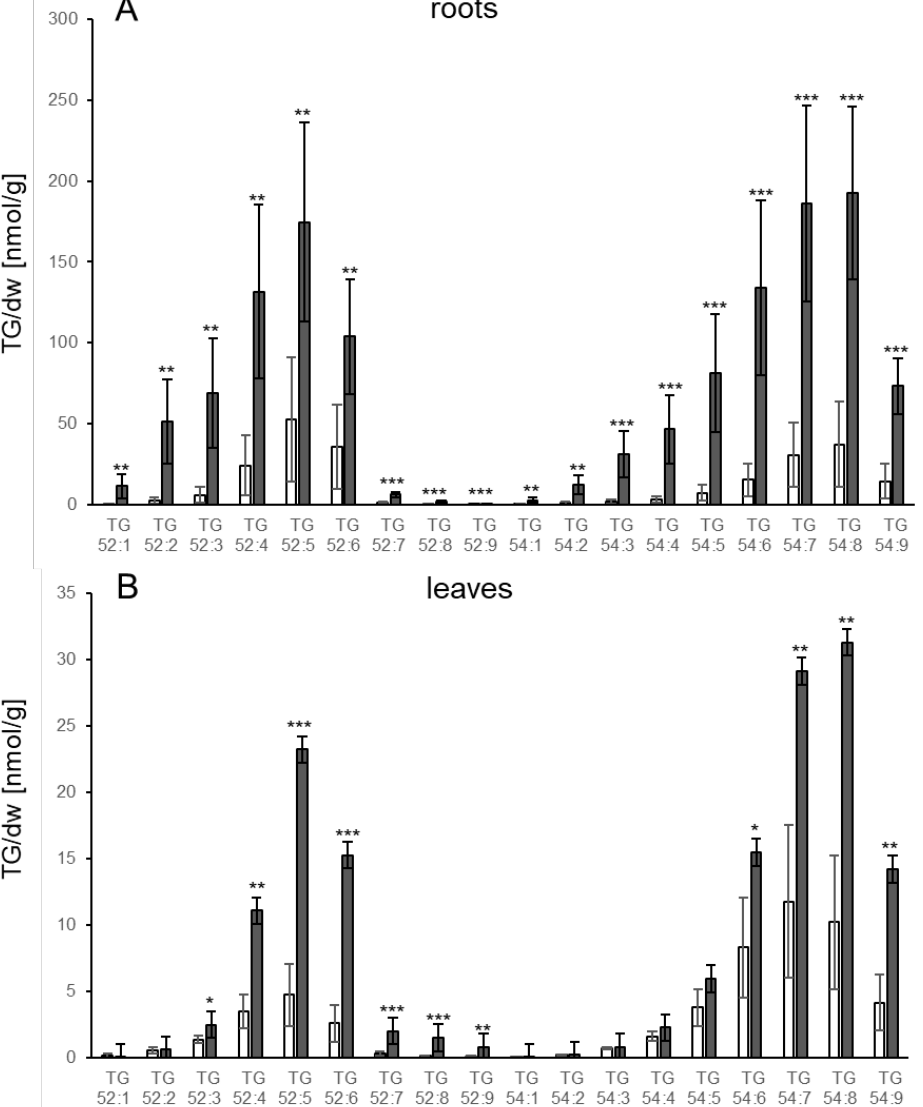
Figure 2. Accumulation of different TG species in ( A ) roots and ( B ) leaves of Col-0 3 d after treatment of roots with V.l. (dark grey bars) or mock (white bars). TG species are characterized by their total number of acyl carbons and the number of double bonds. TG levels [nmol/g dry weight] shown represent the mean of five biological replicates ± sd. Asterisks indicate significant differences between the V.l. treated samples and the corresponding mock treated sample (* p < 0.05; ** p < 0.01; *** p <